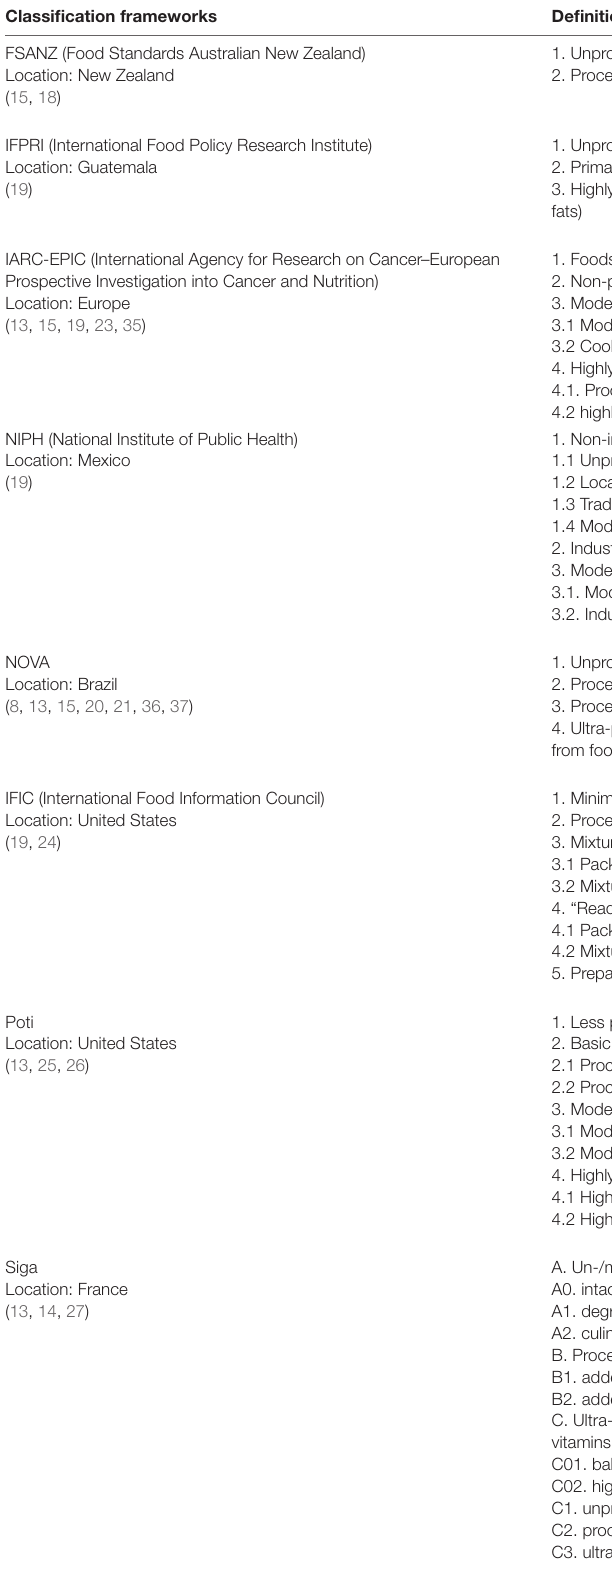
TABLE 1 | Food processing classification frameworks from around the